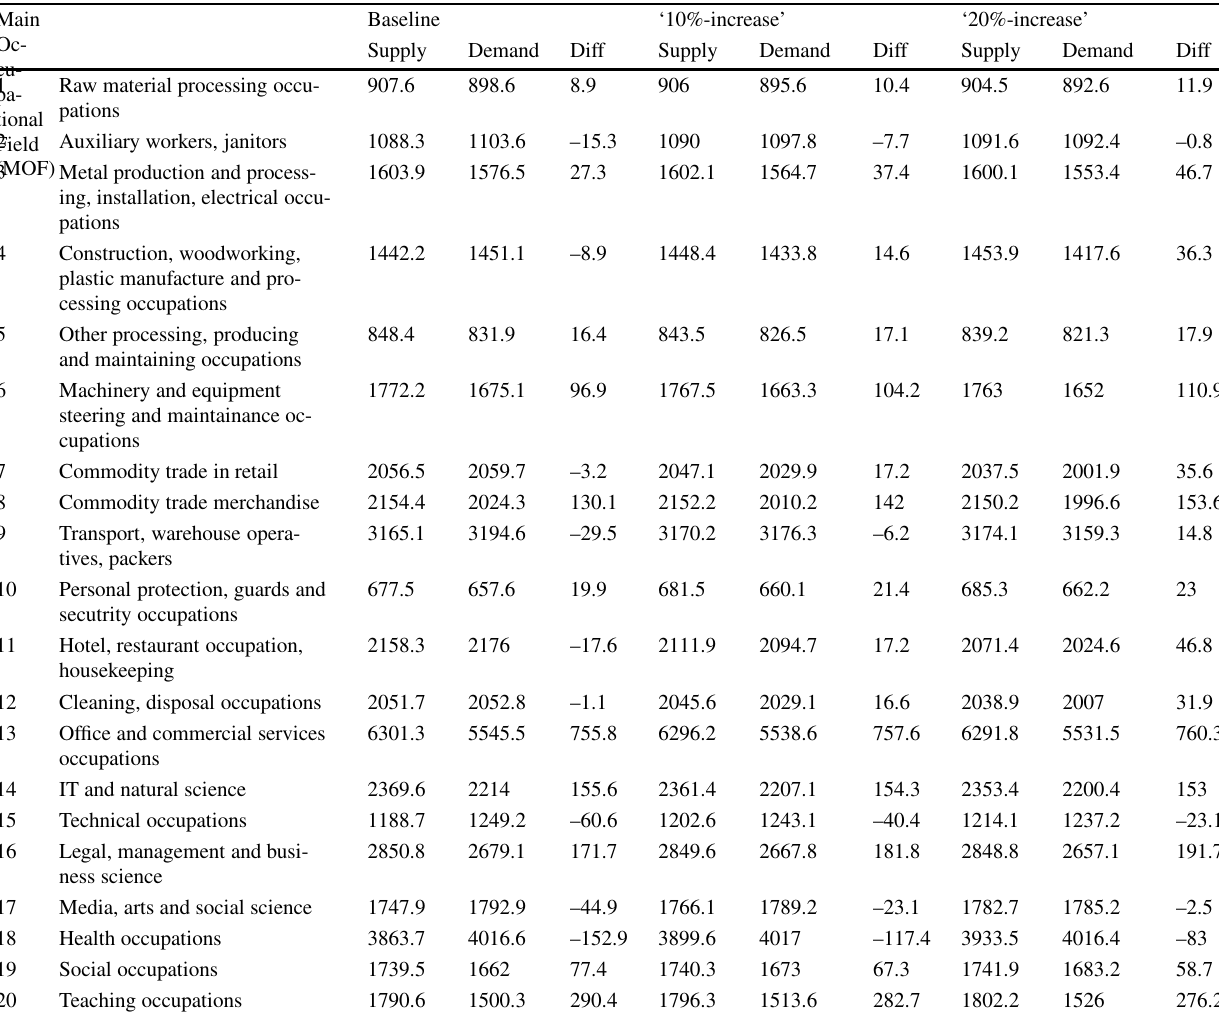
Table 4 Labour demand and supply in 1000 persons by 20 MOF in 2030 in baseline model and different wage scenarios Main